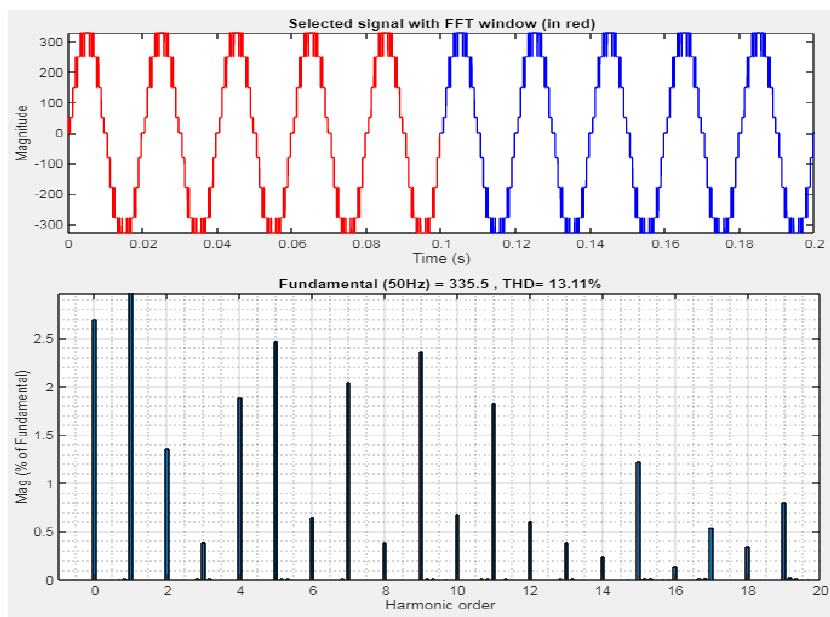
Figure 33. FFT spectrum of the output voltage under PSC.